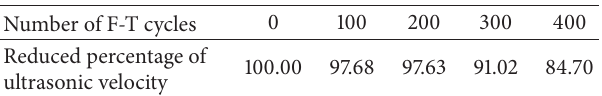
Table 7: Reduced percentage of ultrasonic velocity of A-E-C subjected to F-T cycles.